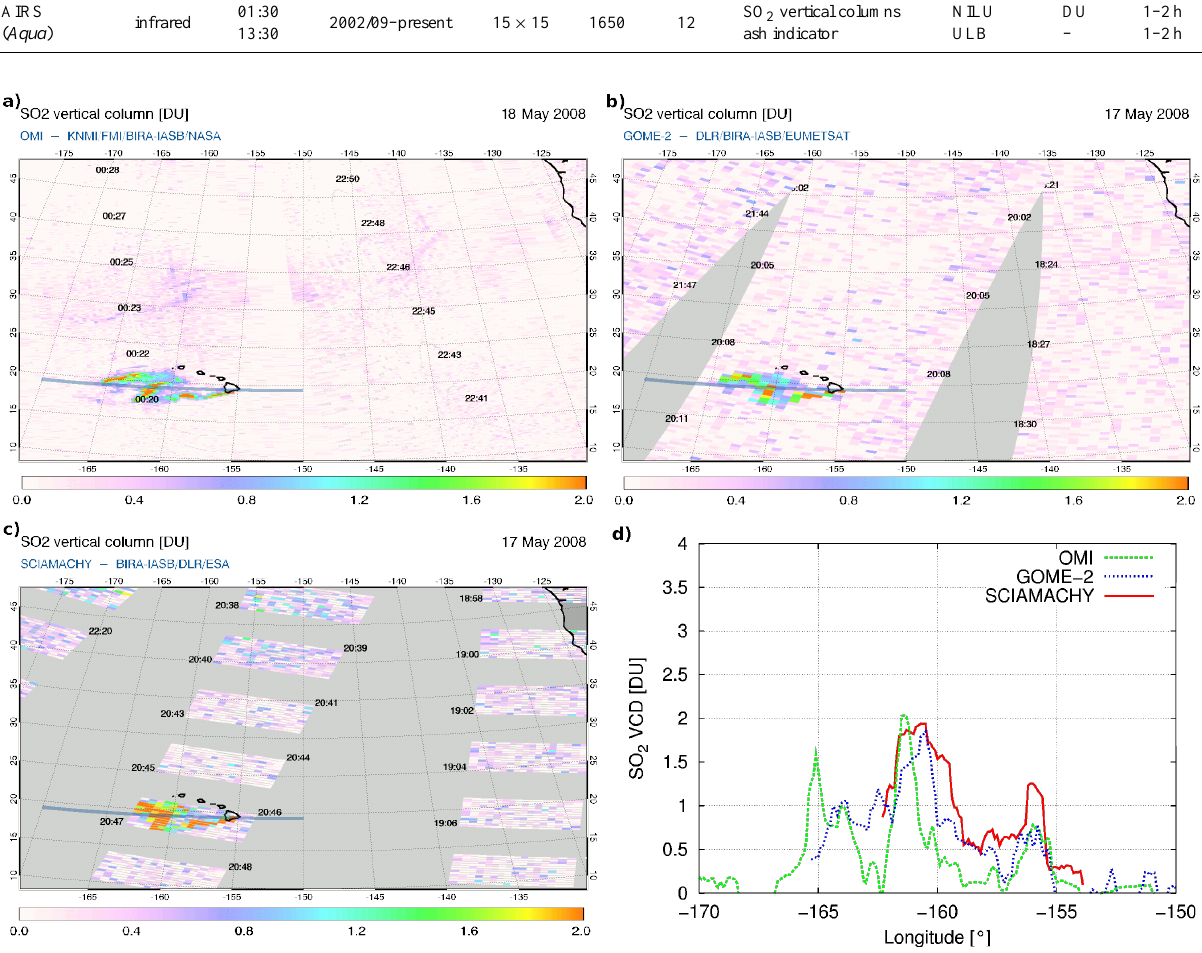
Fig. 2. SO 2 VCD images by (a) OMI, (b) GOME-2A and (c) SCIAMACHY. The lower right plot (d) shows the SO 2 VCDs for a fixed latitude of 19.4 ◦ N (blue line in the SO2 images) as a function of longitude during an eruption of Kilauea Volcano (155.29 ◦ W, 19.42 ◦ N), 17–18 May